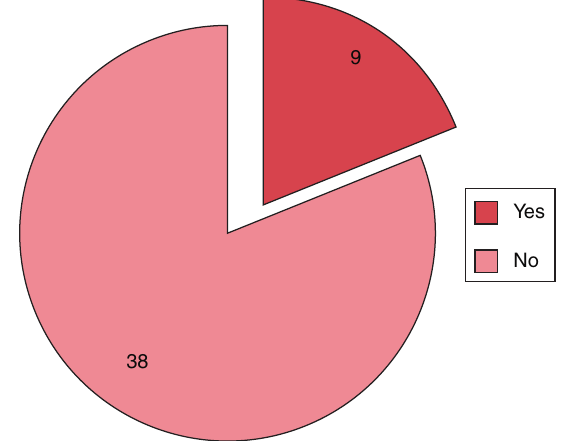
Figure 5 Knowledge about the different degrees of hearing loss ( n = 47).